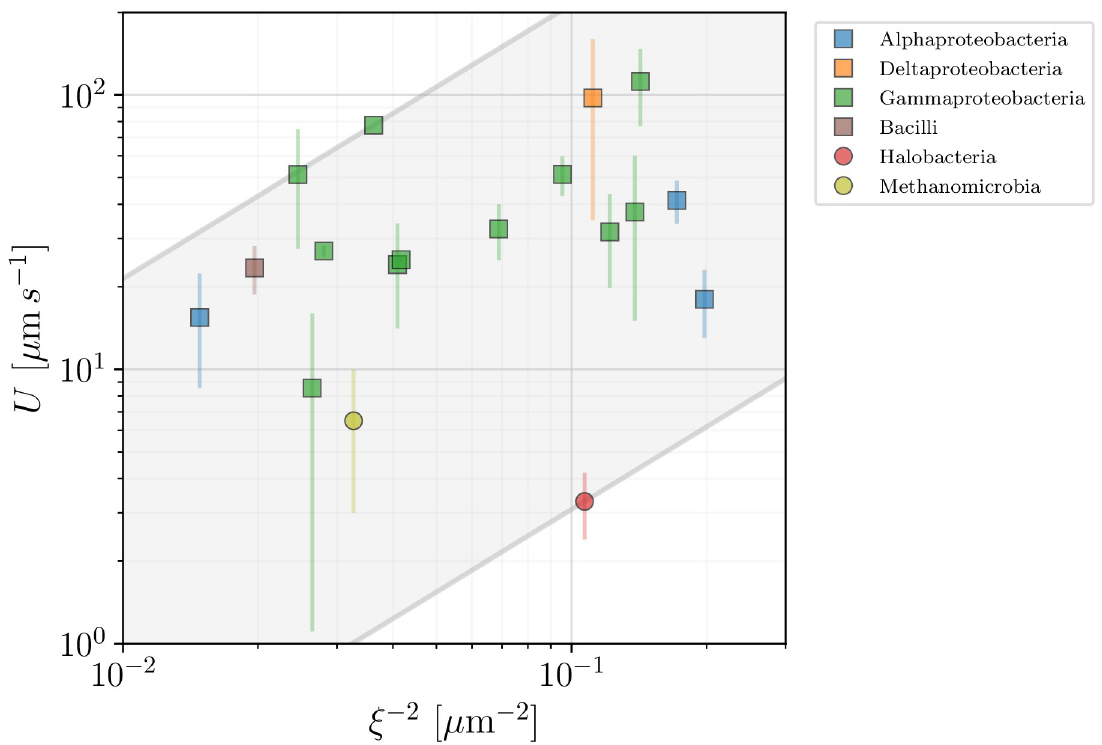
Fig 7. Propulsion speed of rod-shaped prokaryotes vs morphological factor 1/ ξ 2 . Bacteria are plotted in squares and archaea in circles with colours used to distinguish between the different taxonomic classes. The plot, along with Eq (14), allows to estimate the range of bacterial motor torques 27.48 − 1907 pN nm, represented by the shaded